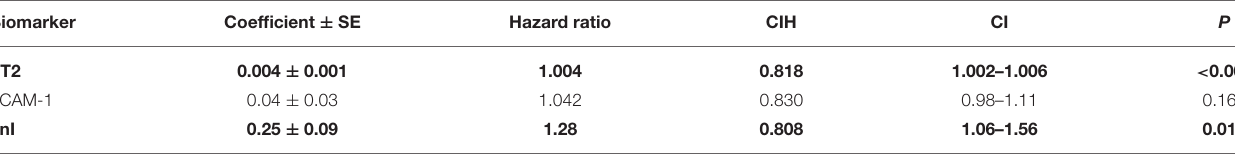
TABLE 5 | Univariate Cox regression for biomarkers associated with post-hospital 1-year FU mortality. Biomarker